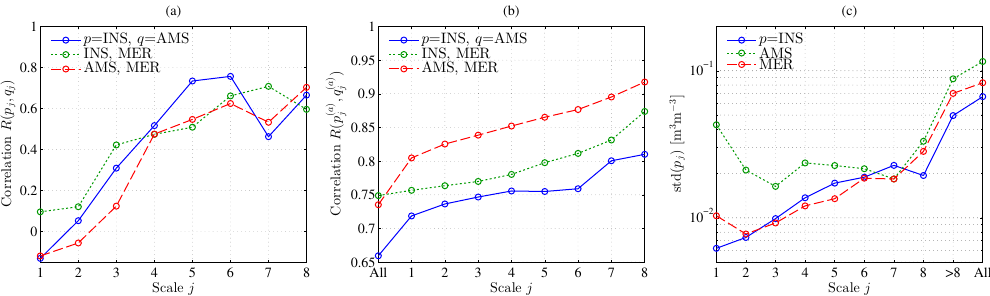
Figure 3. Comparisons of correlation R and SD between INS, AMS and MER at scale levels. (a) compares the correlation between their detail time series p j , and (b) compares between their approximation time series p ( a ) statistics of the original time